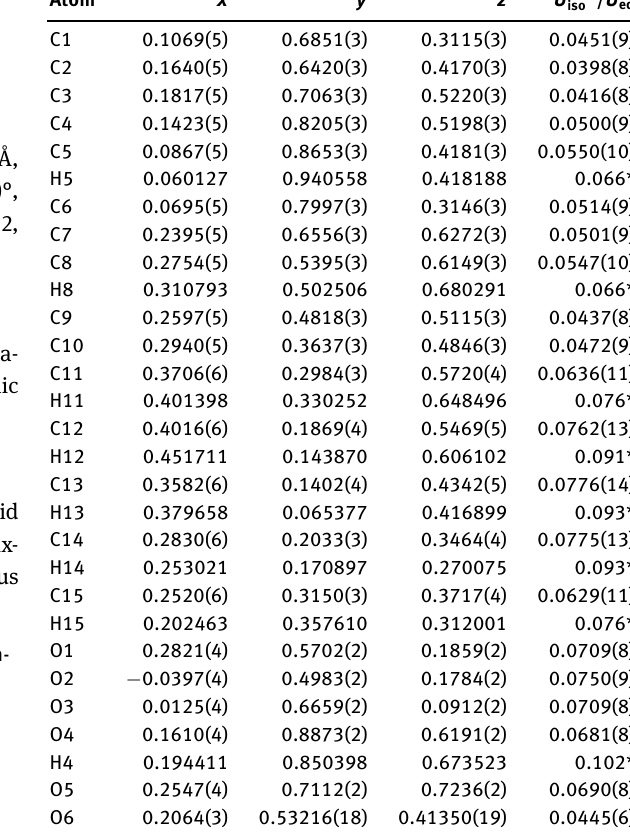
Table 2: Fractional atomic coordinates and isotropic or equivalent isotropic displacement parameters (Å 2